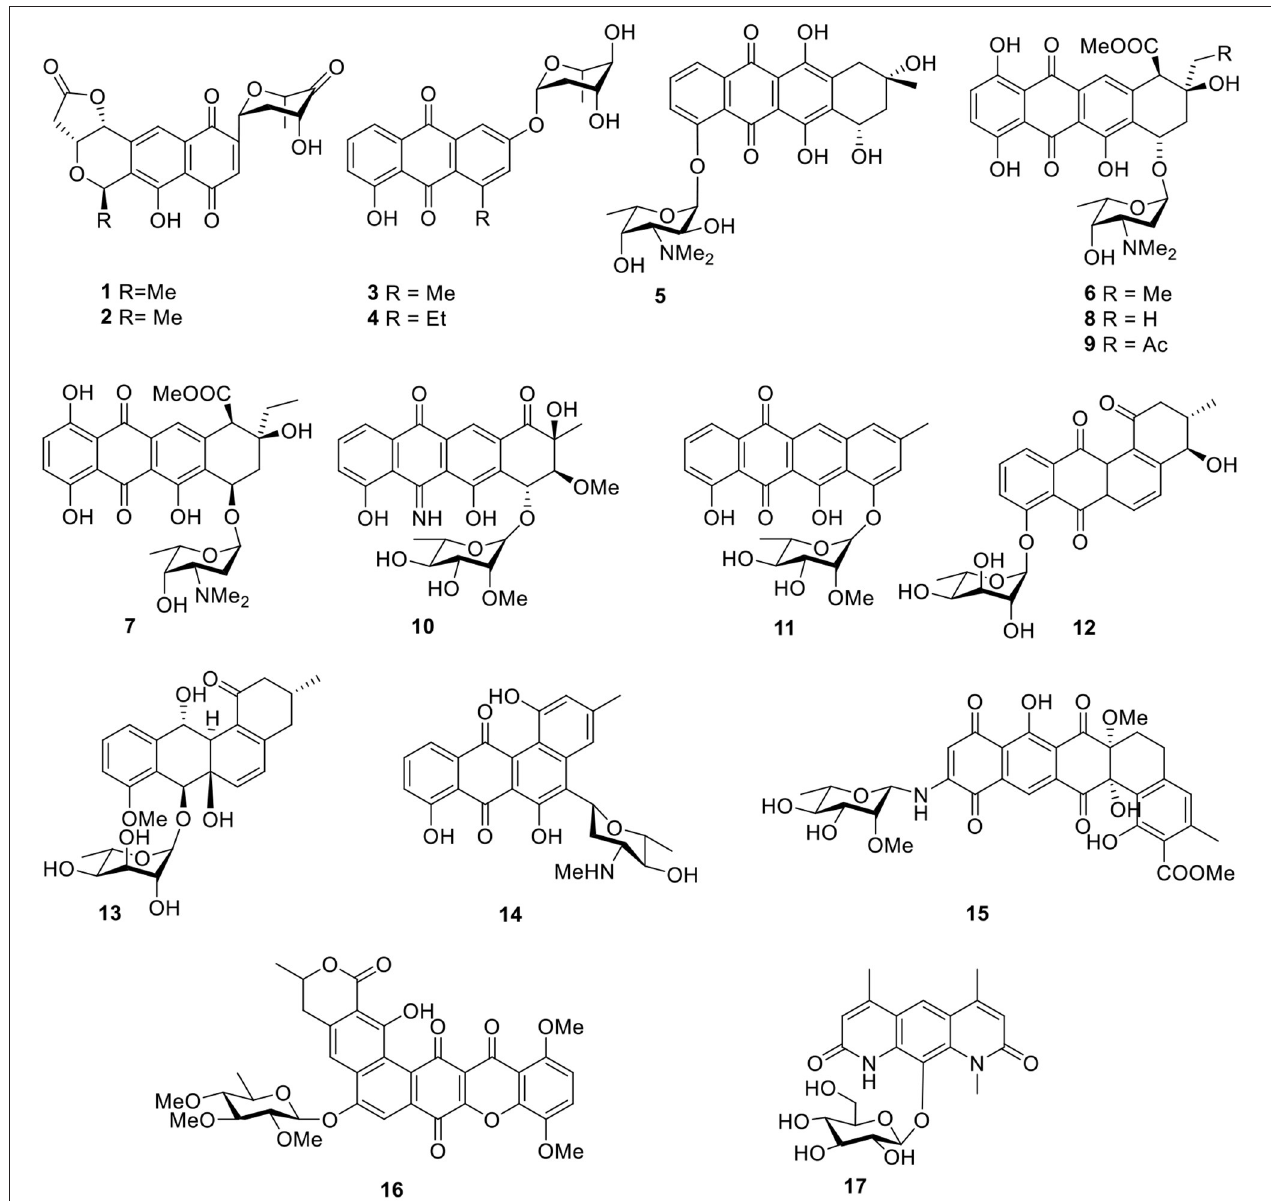
FIGURE 2 | Chemical structures of compounds 1–17 derived from marine-sourced